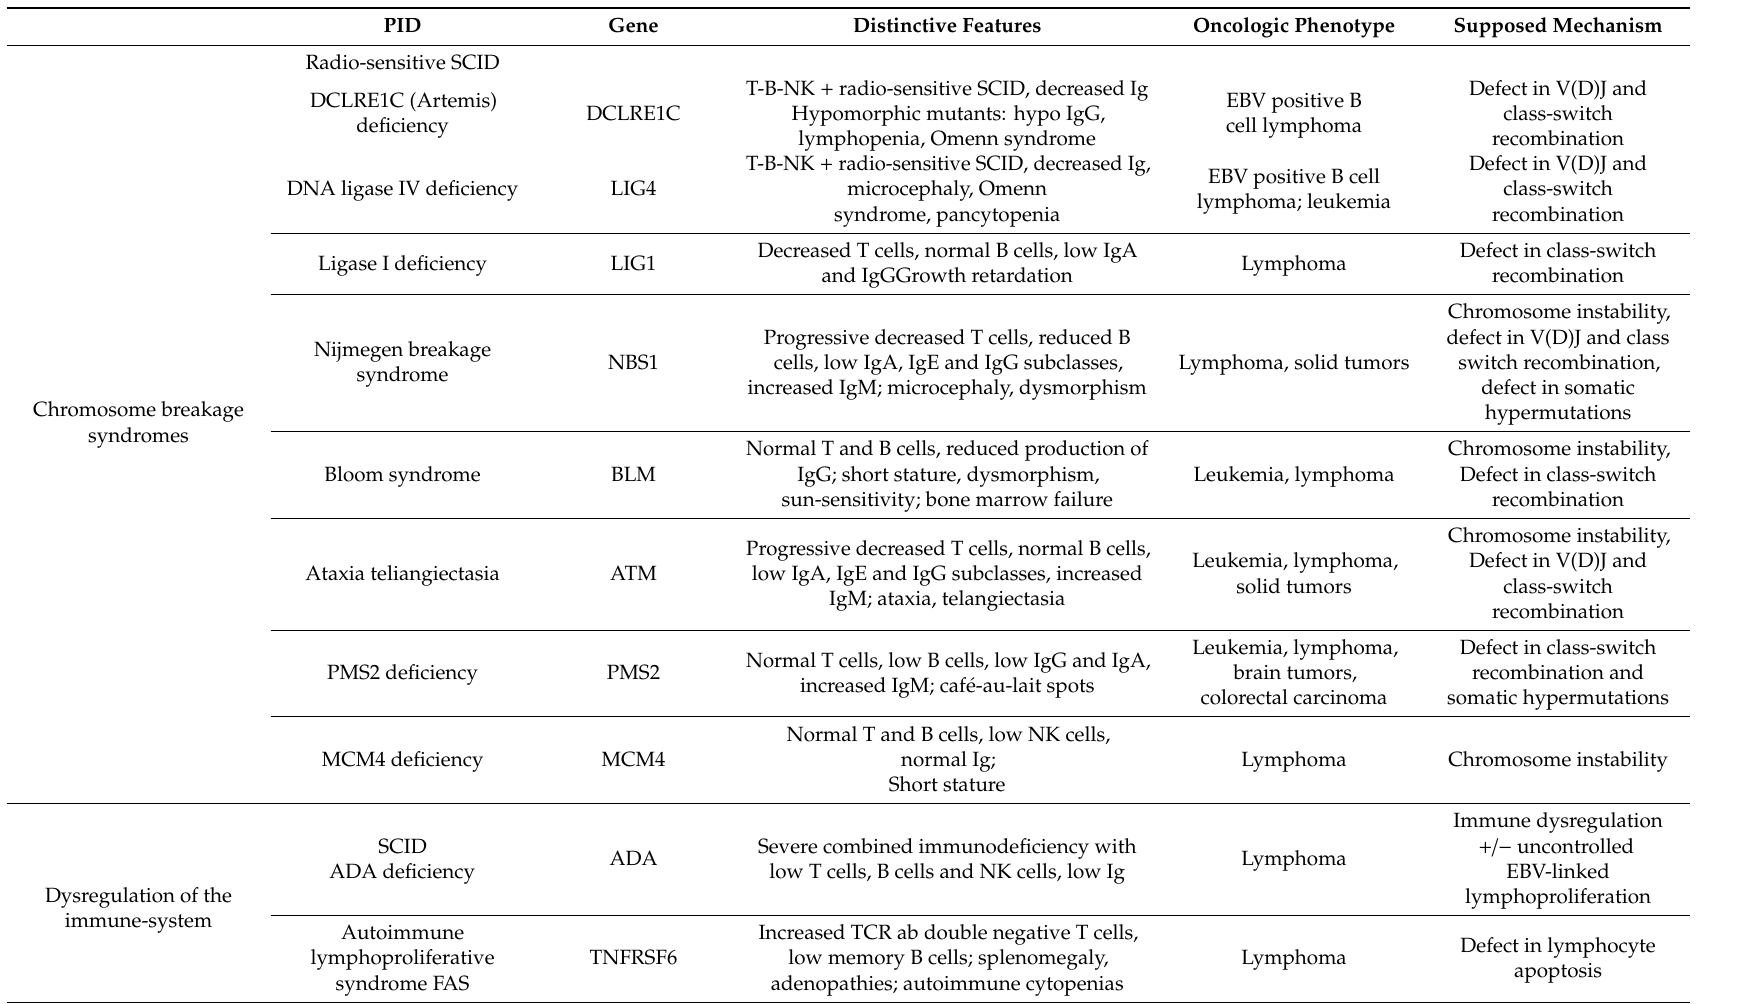
Table 1. Lists primary immunodeficiencies (PIDs) prone to cancer and their corresponding gene defect.